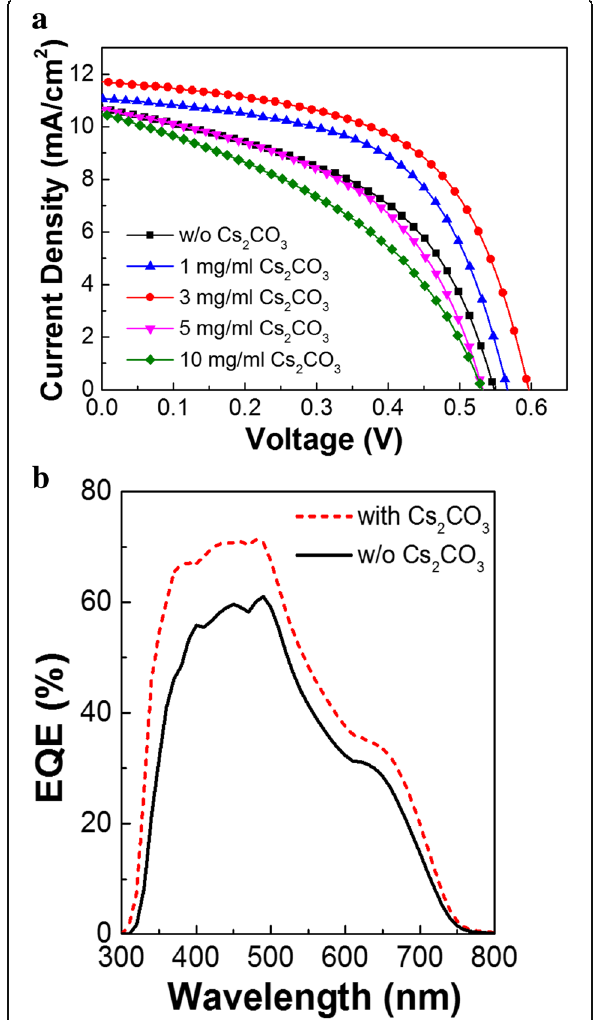
Fig. 3 a Current density – voltage ( J – V ) characteristics and b EQE spectra of